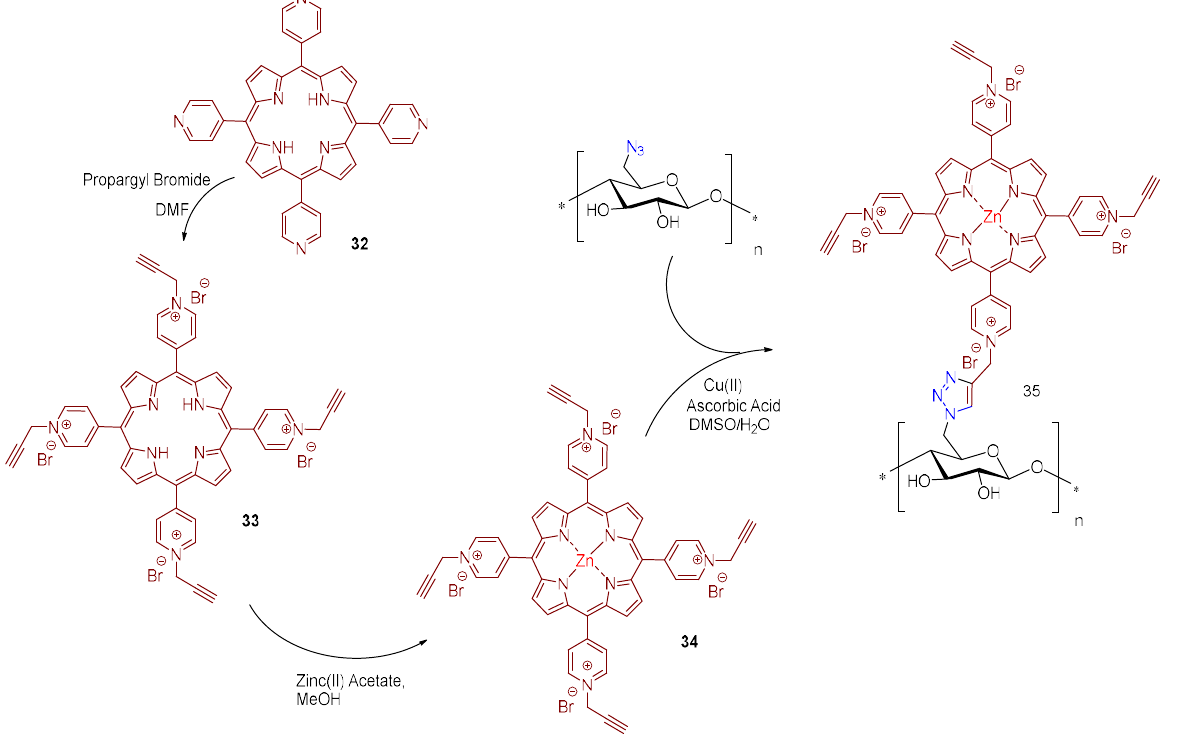
Figure 24. Synthetic strategy adopted by Zerrouk and co-workers to obtain the propargylated cationic porphyrin 34 and to graft it into the azide kraft pulp (adapted form [171] ).